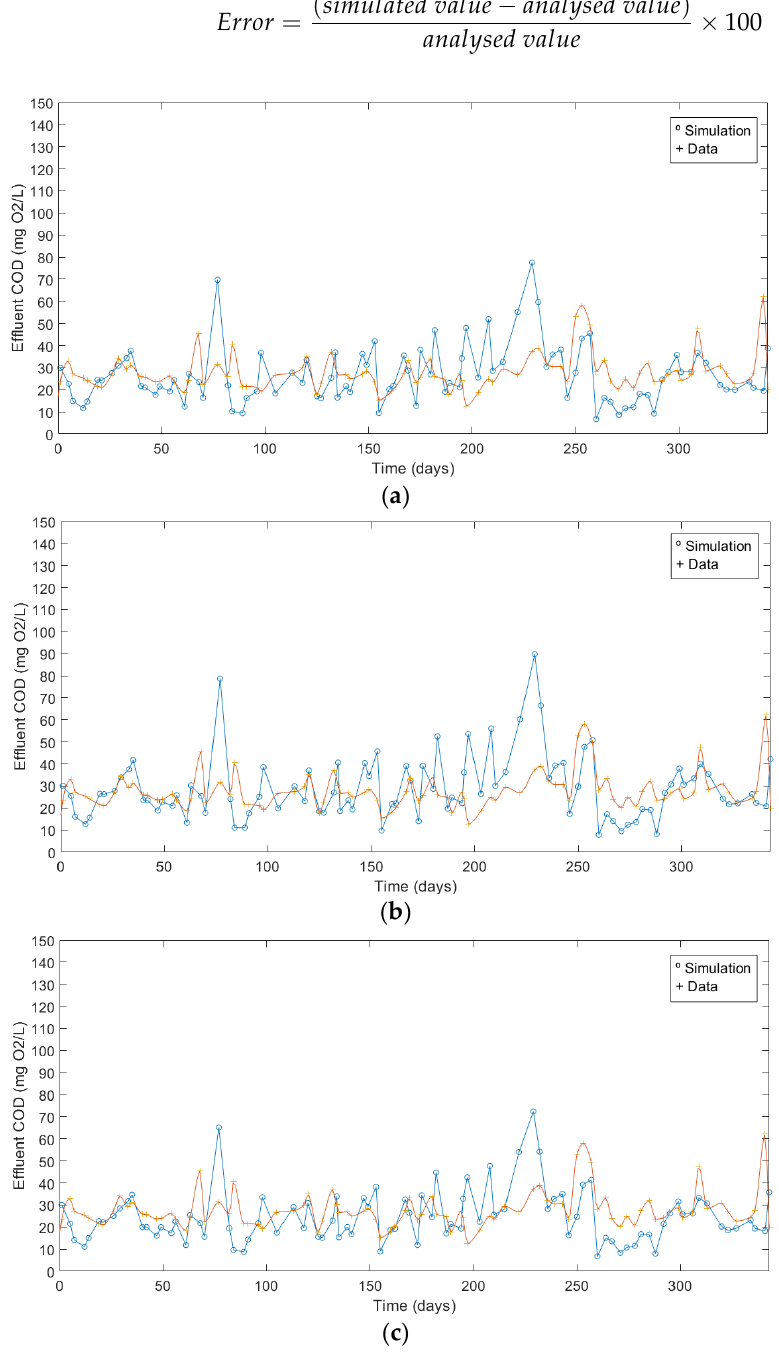
Figure 5. Fine tuning on μ H for Y H = 0.60. ( a ) μ H , max = 0.40 d −1 , ( b ) μ H , max = 0.38 d −1 and ( c ) μ H , max = 0.42 d −1 .